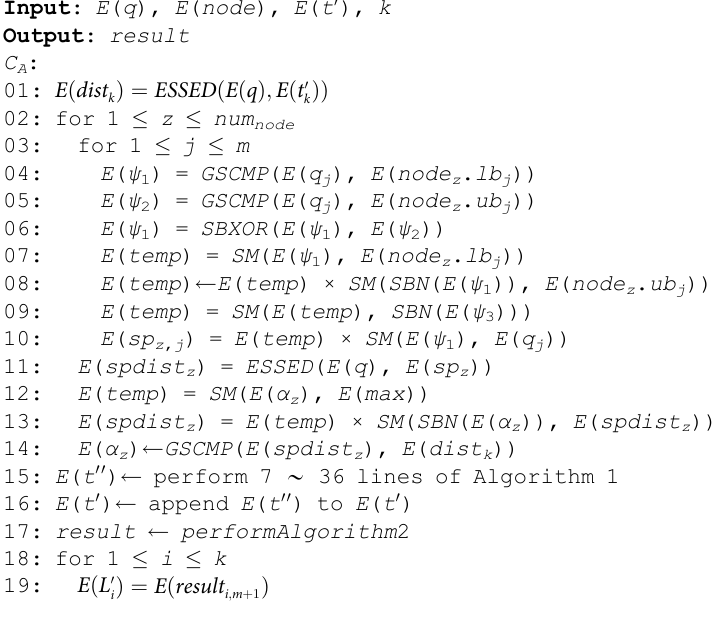
Algorithm 5 k-nearest neighbors verification phase